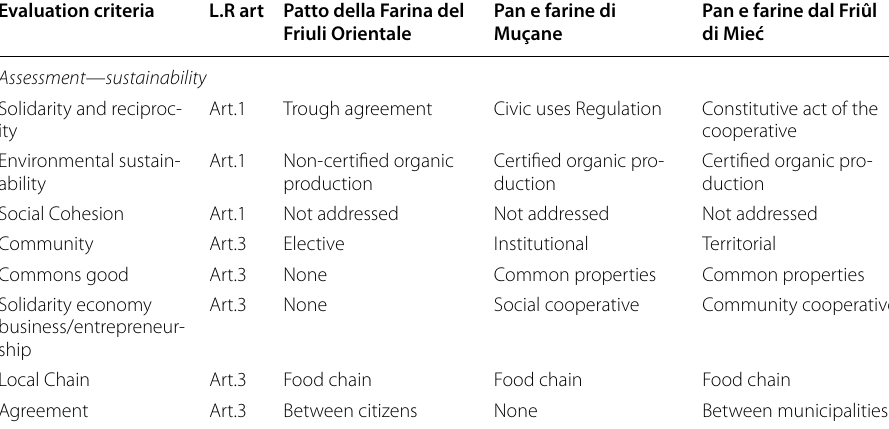
Table 5 Assessment—coherence with regional law (4/2017) Evaluation